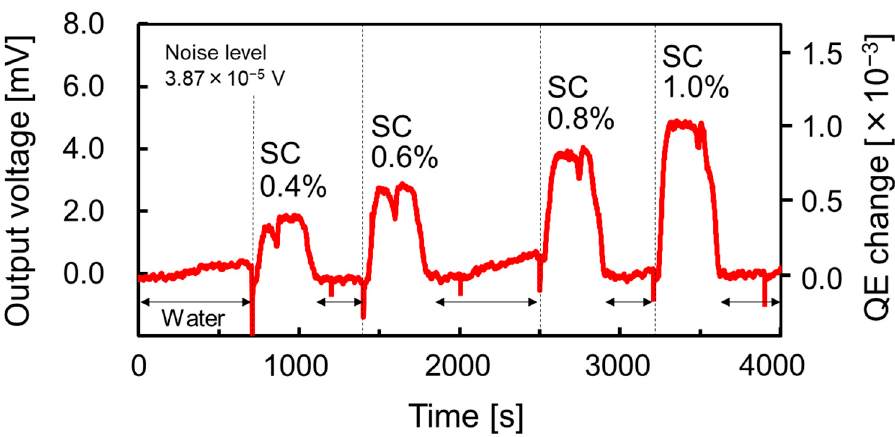
Figure 9. Sensorgram for aqueous solutions measured by single-wavelength dual PD method. “SC” indicates that the sucrose solution with each concentration is introduced around SP antenna as analyte. The concentrations of sucrose solutions are based on weight ratio.